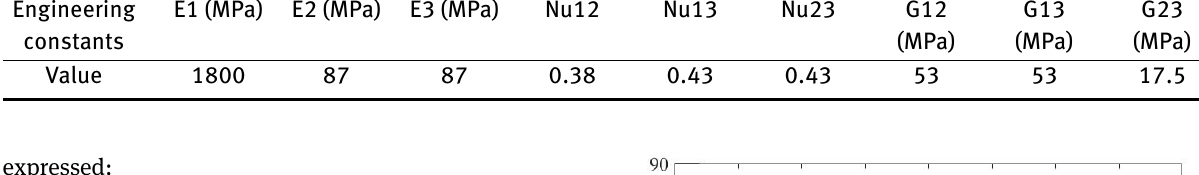
Table 3: Engineering Constants of Composite Materials Engineering